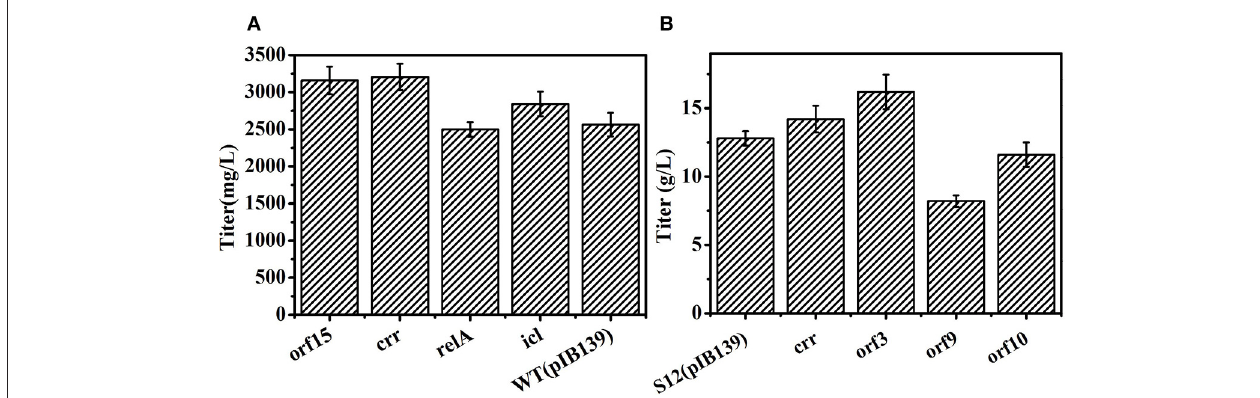
FIGURE 7 | Overexpression of related genes to improve salinomycin in S. albus . (A) Overexpression of genes orf15 , crr , relA , icl in wild type strain DSM41398. (B) Overexpression of genes crr , orf3 , orf9 , orf10 in the industrial strain S12. Error bars indicate standard error of the